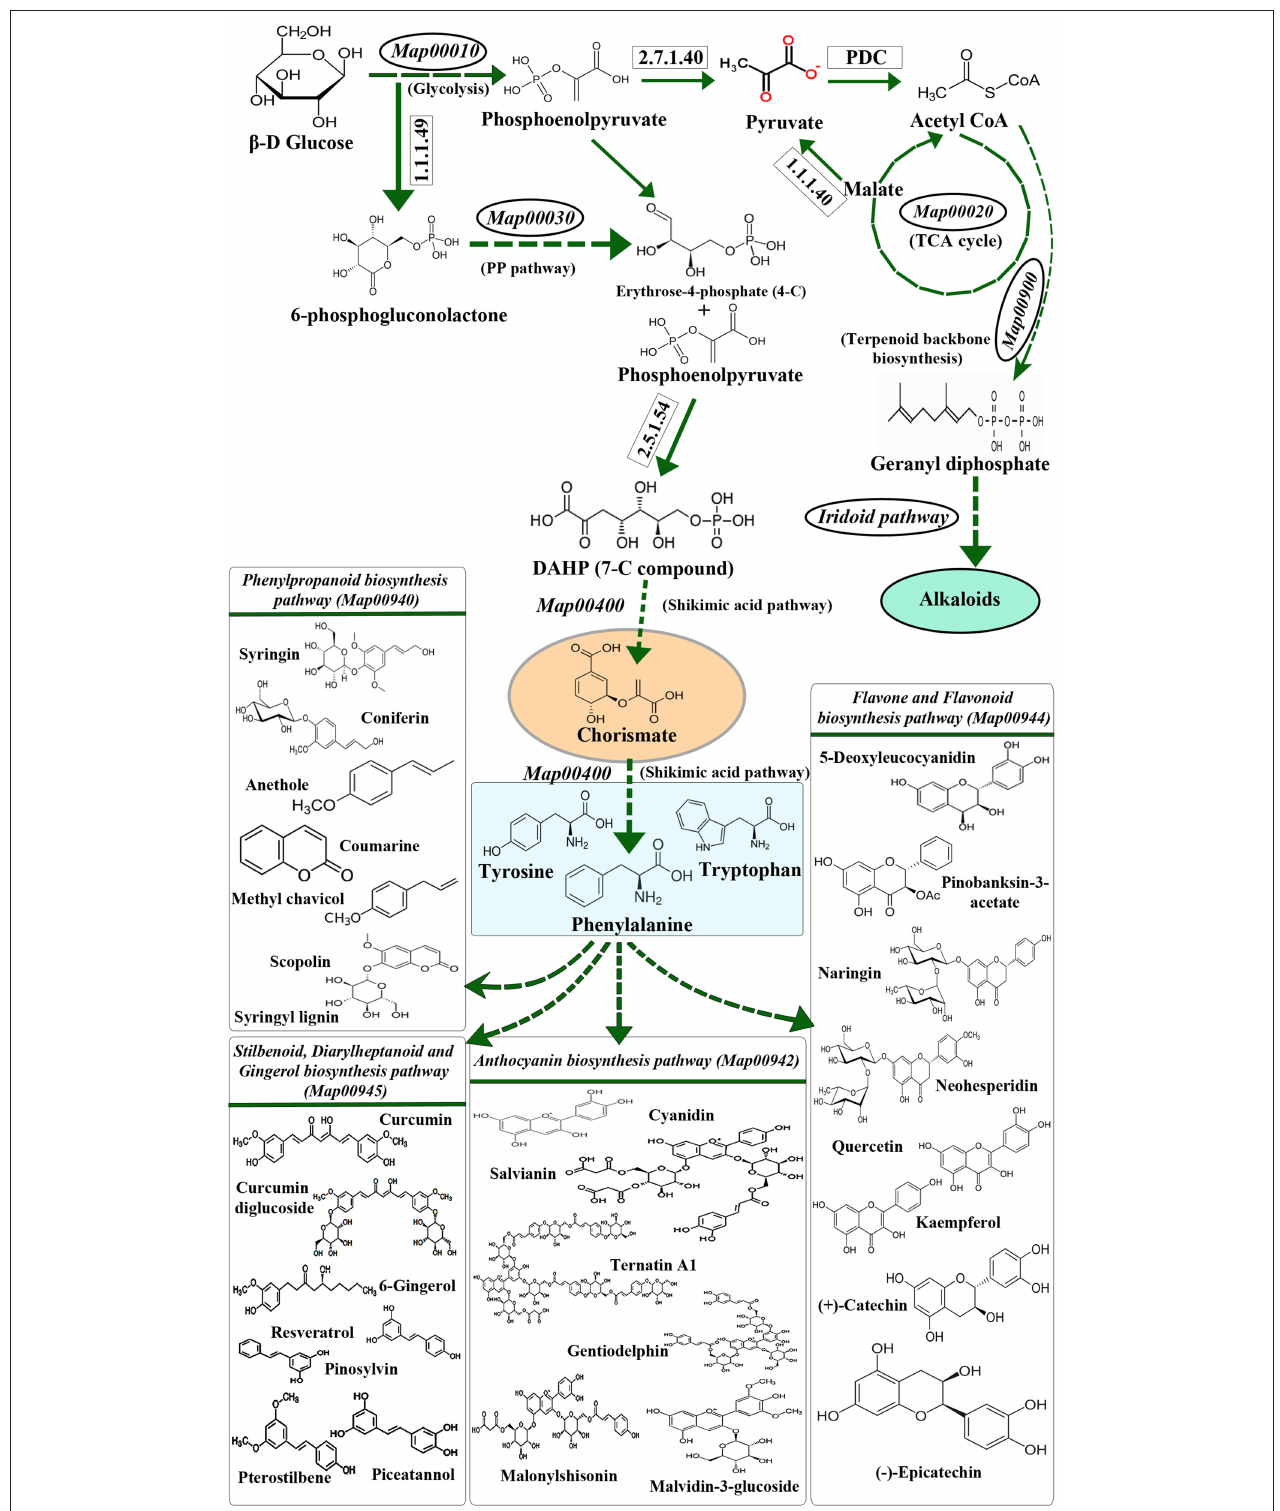
FIGURE 1 | The biochemical link between primary and specialized metabolism. Primary and major specialized metabolisms (example, phenylpropanoid metabolism) are interconnected through intermediates like chorismate. The precursors for the synthesis of amino acids phenylalanine, tyrosine and tryptophan are derived through the Shikimic acid pathway and utilized in the biosynthesis of various specialized metabolites via the Phenylpropanoid biosynthesis pathway. (Map numbers indicate the KEGG pathway ID; PP pathway refers to Pentose phosphate pathway; PDC refers to Pyruvate Dehydrogenase Complex).